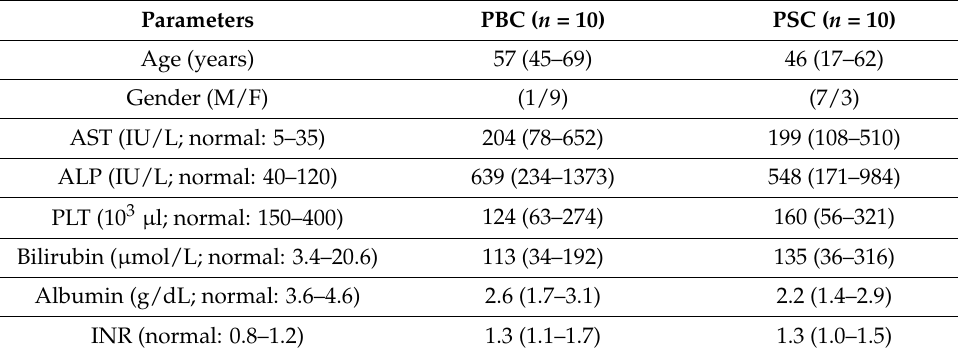
Table 1. Baseline clinical characteristics of analyzed PBC and PSC patients (mean, range